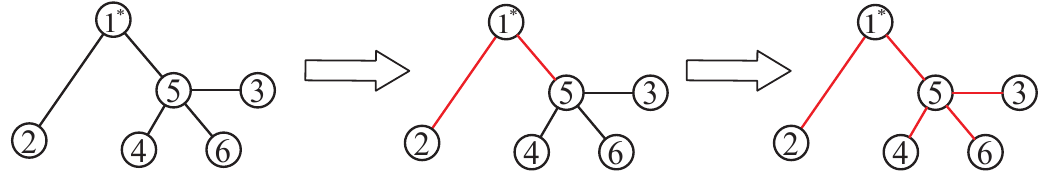
Figure 2. The process of constructing a breadth first search algorithm (BFS) tree from the root node marked with the